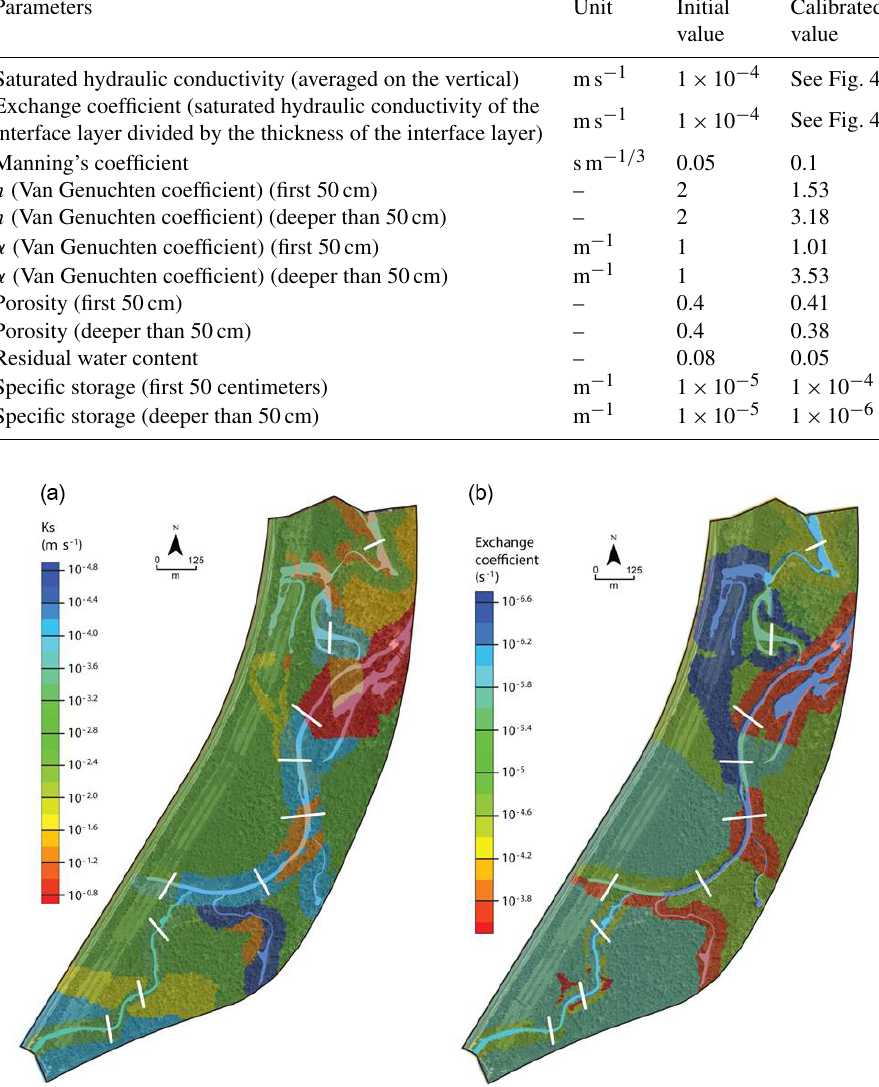
Figure 4. Calibrated fields of saturated hydraulic conductivity in the subsurface compartment (a) and exchange coefficient between surface and subsurface compartments (b)